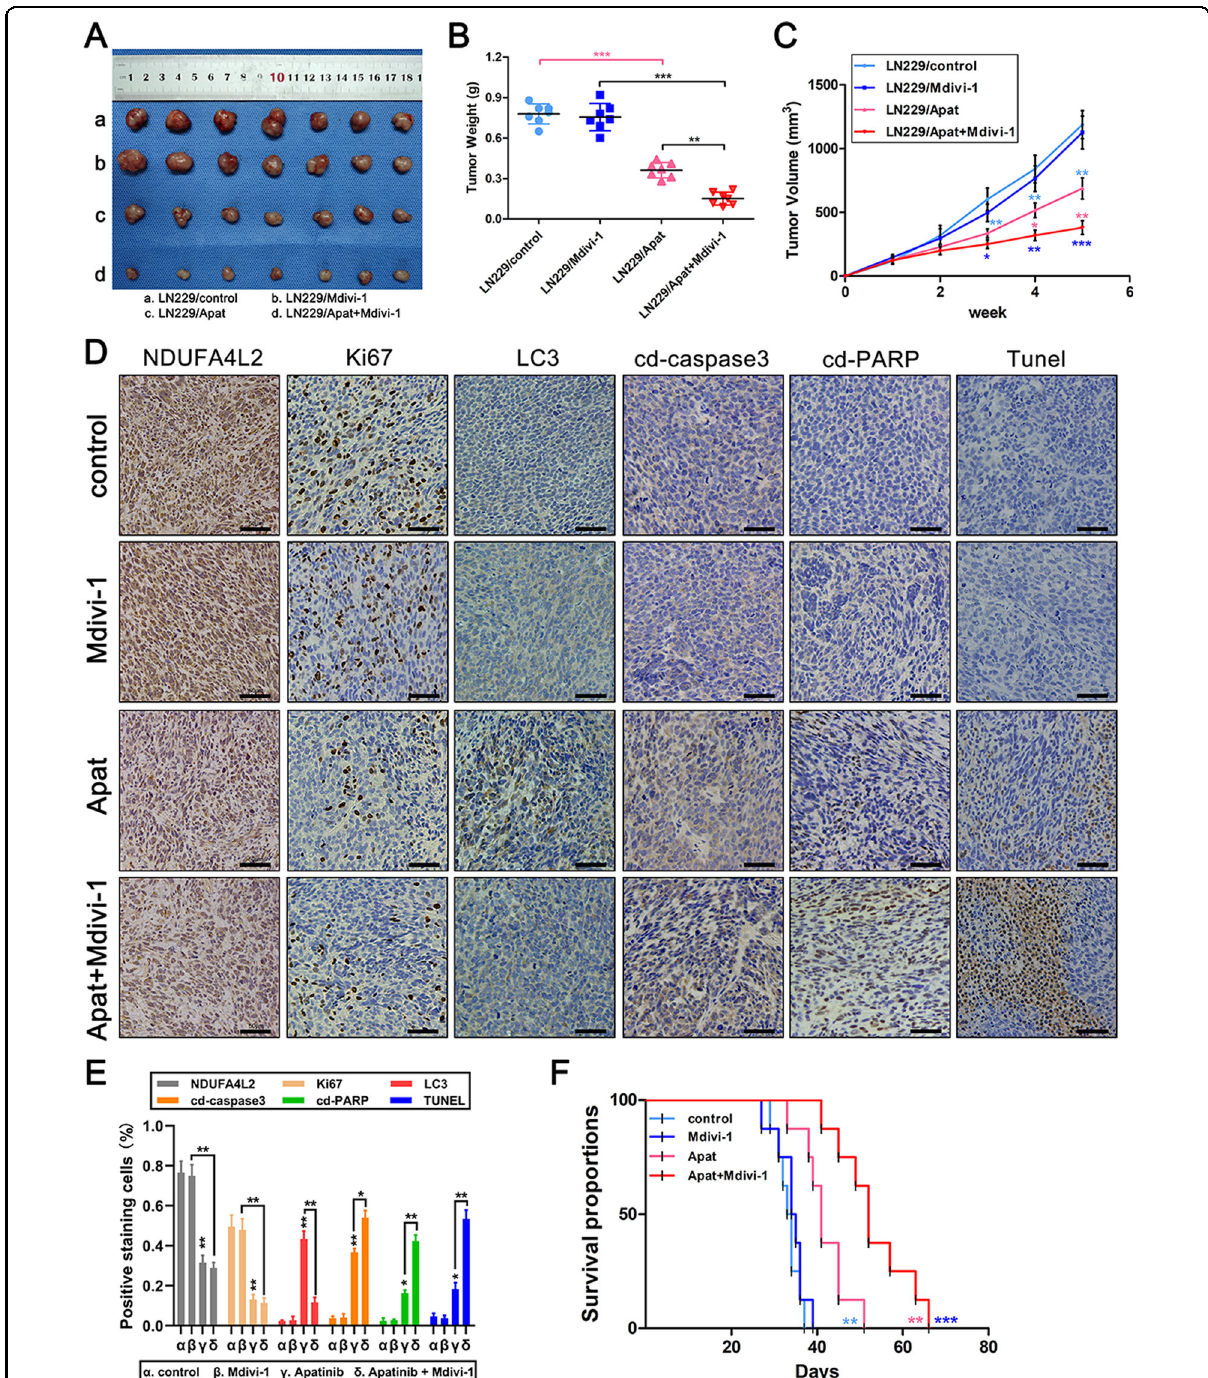
Fig. 6 Tumor suppression induced by apatinib targeting of NDUFA4L2 is enhanced by Mdivi-1 in vivo. A – C Nude mice carrying tumors from LN229 cells treated with apatinib (50 mg/kg), Mdivi-1 (3 mg/kg), or apatinib + Mdivi-1 are shown ( n = 7). Average tumor weights were calculated for all groups. Tumor growth curves were calculated for each week. D , E NDUFA4L2, Ki67, LC3, cleaved-caspase 3, and cleaved-PARP expression levels, as well as positive cell numbers, were determined by immunohistochemical staining; apoptosis was assessed by TUNEL assay. Scale bar = 50 μ m. F Tumor xenografts were established by subcutaneous inoculation of LN229 cells into the armpit of the right upper limb of nude mice. Survival rates of the four groups (control, Mdivi-1, apatinib, and apatinib + Mdivi-1) of nude mice are represented in a Kaplan – Meier plot ( n = 8). Means ± SDs of triplicate experiments are plotted. * p < 0.05, ** p < 0.01, *** p < 0.001.